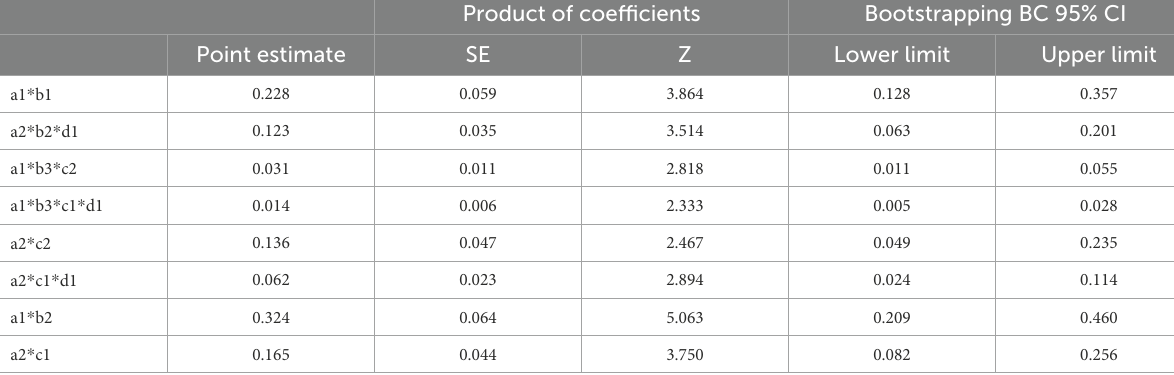
TABLE 5 Indirect effects of social identity on self-identity via novel posting, information support, and sense of